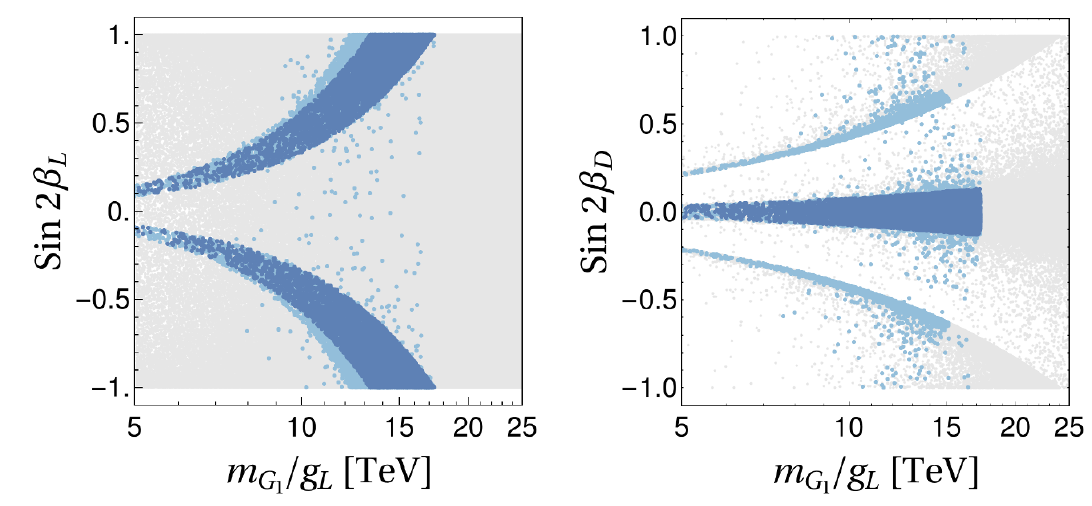
Figure 3 . sin 2 (cid:12) L;R vs. m G (cid:12)gure